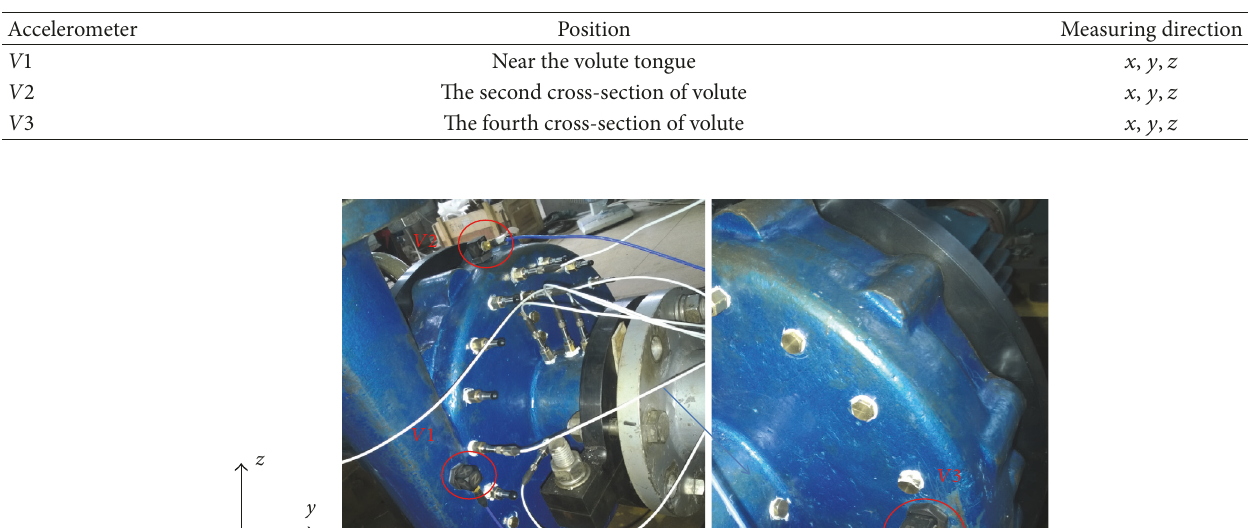
Table 2: Positions and measuring directions of the accelerometers.